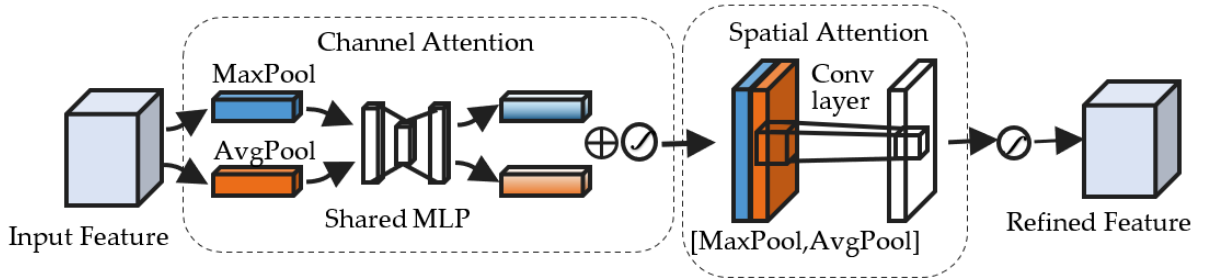
Figure 2. Structural diagram of the convolutional block attention module.